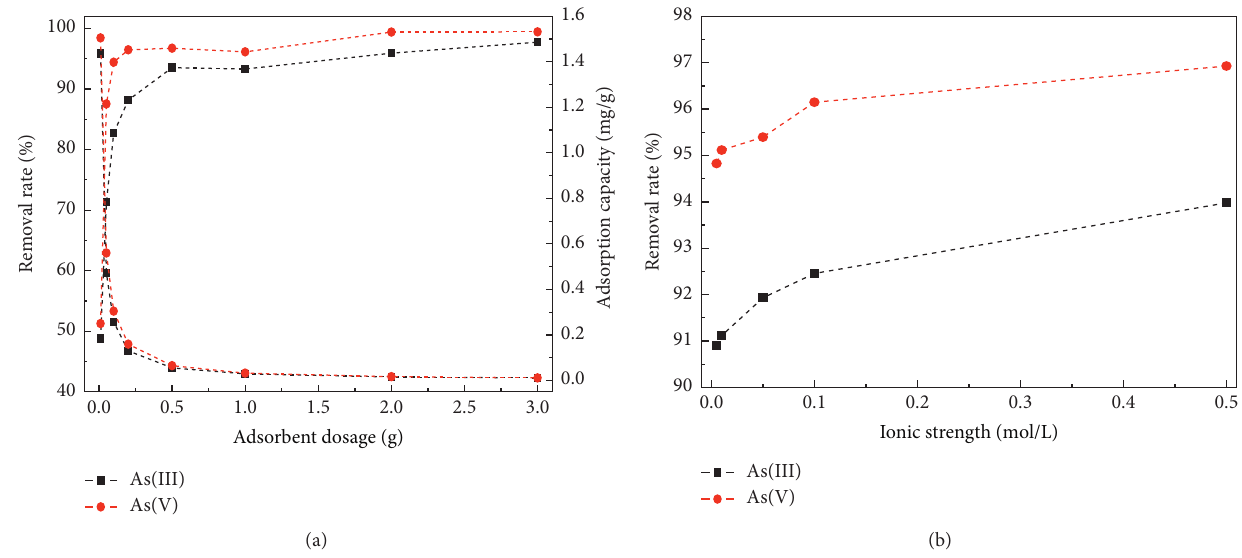
Figure 6: The effects of adsorbent dosage and ionic strength on arsenic removal at room temperature with reaction conditions: pH � 8, initial As concentration 1.3 mg/L, and solution volume 25ml. (a) Adsorbent dosage (g). (b) Ionic strength (mol/g).